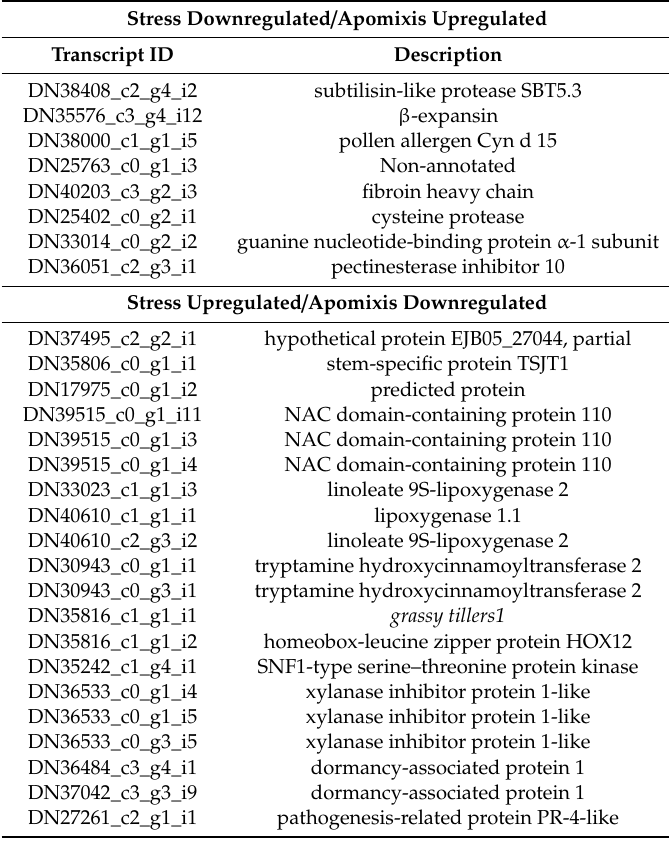
Figure 3. Venn diagrams comparing the weeping lovegrass differentially expressed (DE) transcripts between control vs. stressed plants with the DE transcripts between apomictic vs. sexual plants. Data for the comparison apo/sex come from Garbus et al. [51]. ( a ) In the intersection between both groups of transcripts, there are 93 in common; ( b ) in the intersection are the common transcripts that are DE in apomictic plants (up- and downregulated) and downregulated under stress conditions; ( c ) in the intersection are the common transcripts that are DE in apomictic plants (up- and downregulated) and upregulated under stress conditions. Table 2. Differentially expressed transcripts between the control and stressed weeping lovegrass flowers showing homology with DE genes between apomixis/sexual flowers obtained previously in E. curvula by Garbus et al. [51]. In the description column the annotation provided by Blast2go was included.